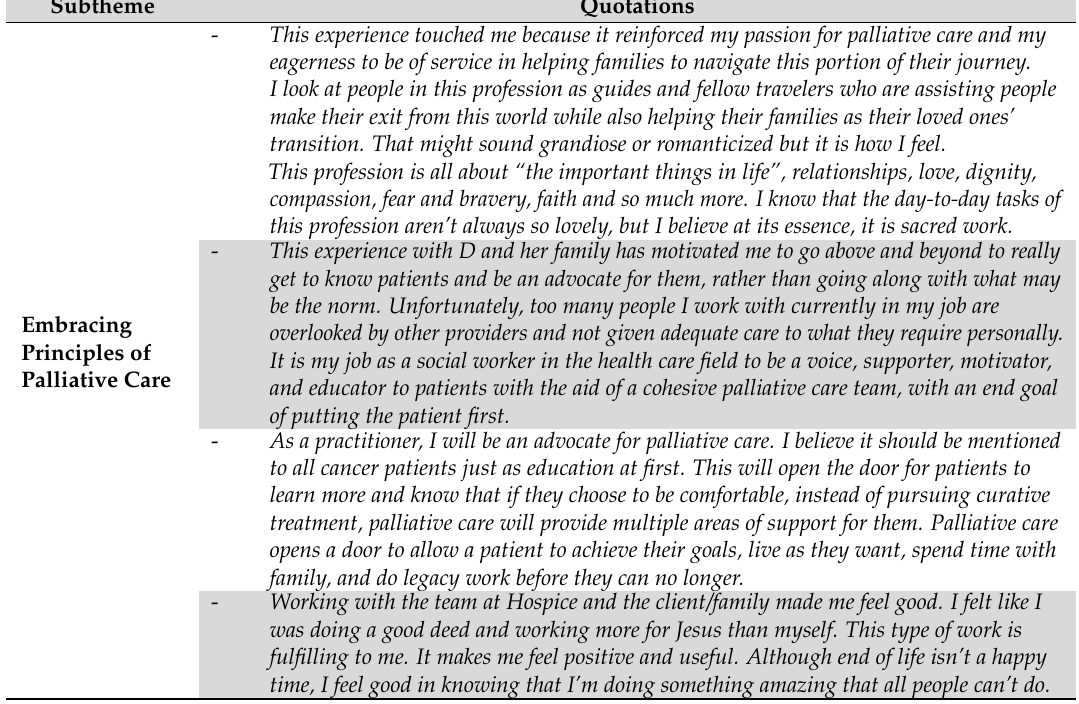
Table 5. Quotes related to the subtheme of embracing principles of palliative